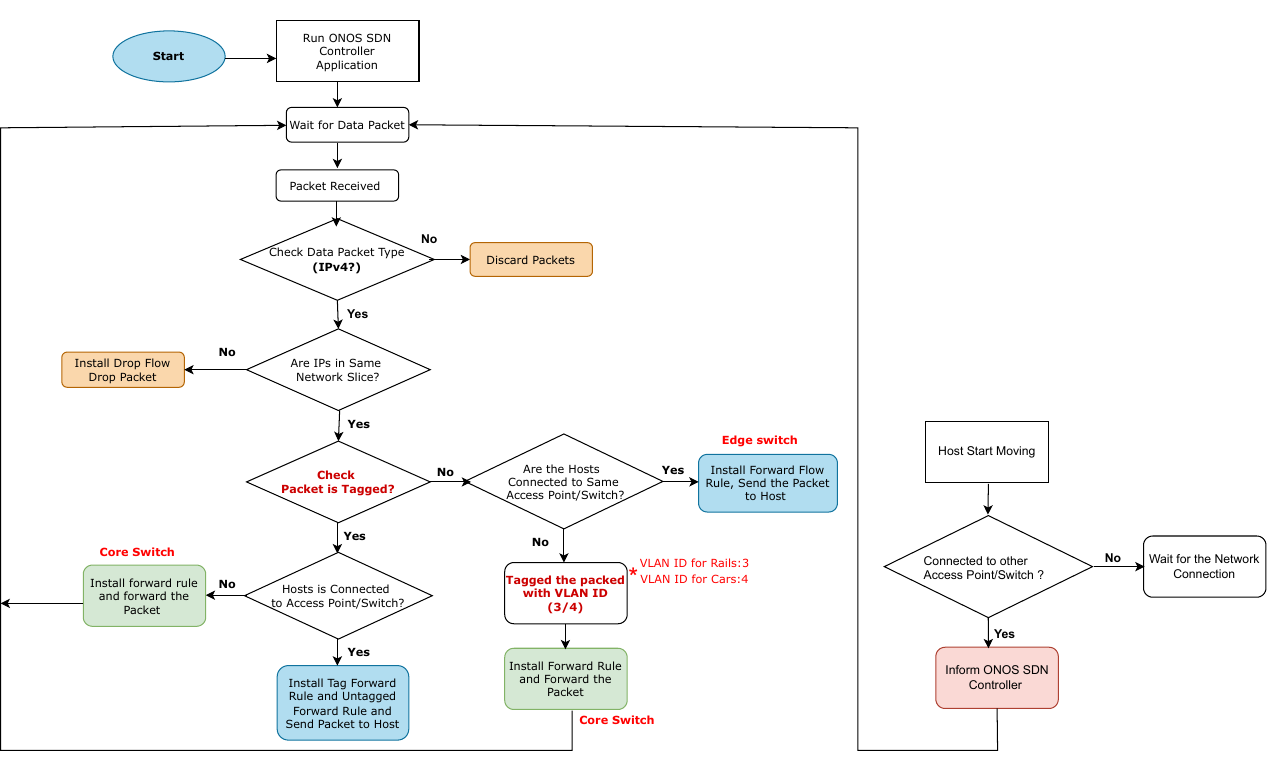
Figure 9. Flow diagram of SDN